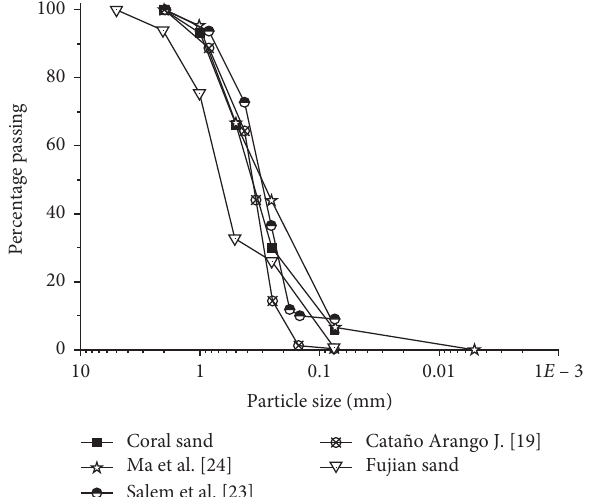
Figure 3: Grain-size distribution curves of various calcareous sands and Fujian sand [19, 23, 24].